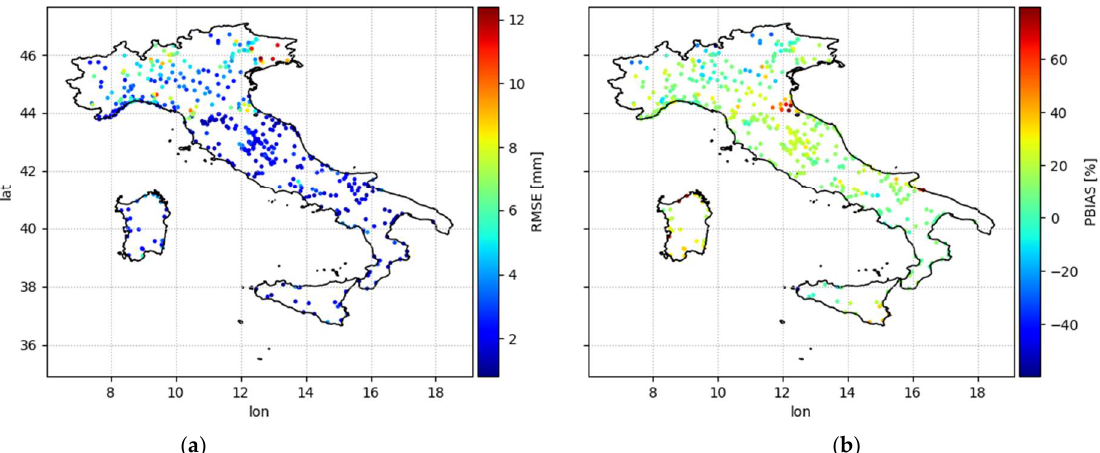
Figure 11. Maps of RMSE ( a ) and PBIAS ( b ) between daily areal mean rainfall from MCM and daily areal mean rainfall from ground-based data.